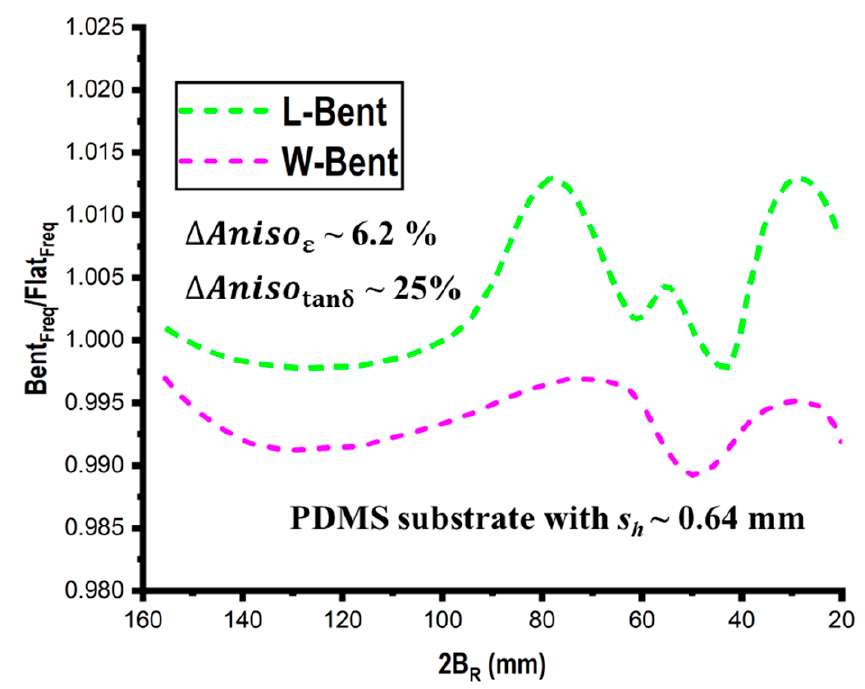
Figure 14. E ff ect of bending and anisotropy of the PDMS on its resonant characteristics. Figure 14. Effect of bending and anisotropy of the PDMS on its resonant